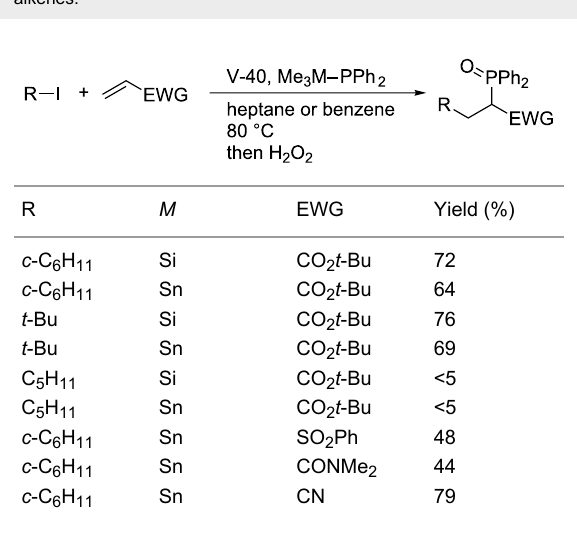
Table 9: Phosphinative radical addition of alkyl iodides to activated